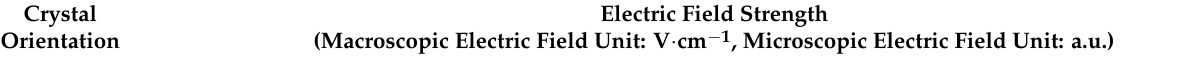
Figure 11. Thermodynamic properties of diamond, after applying different electric fields in the [111] crystallographic direction of diamond.